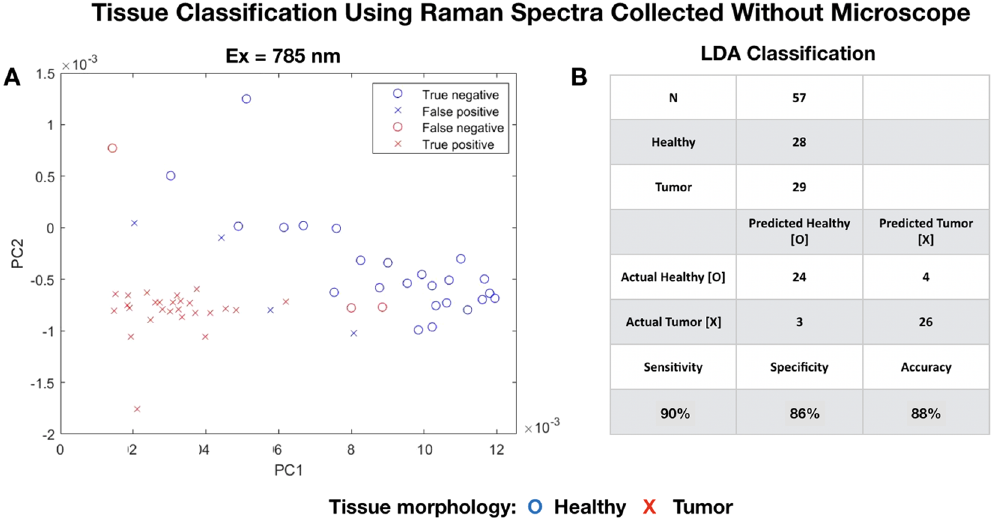
Figure 8. Tissue Classification Using Raman Spectra Collected Without Microscope. Figure 8 depicts the PCA- LDA identification of two spectral classes for tissue regions that by visual morphological classification were either tumor-rich ( ) or healthy ( ). We utilized 3 PCA factors (Table 3) extracted from the 785 nm data as inputs for LDA classification. Fig. 8A is a plot of PC1 and PC2 factors extracted data from 57 targets in tissue regions that appeared either macroscopically healthy (N = 28) or tumor-rich (N = 29). LDA ( B ) classifies 24 of the 28 spectra from healthy regions as healthy, and 26 of 29 spectra from tumor-rich regions as pathological (sensitivity = 90%, specificity = 86%, and accuracy = 88%).